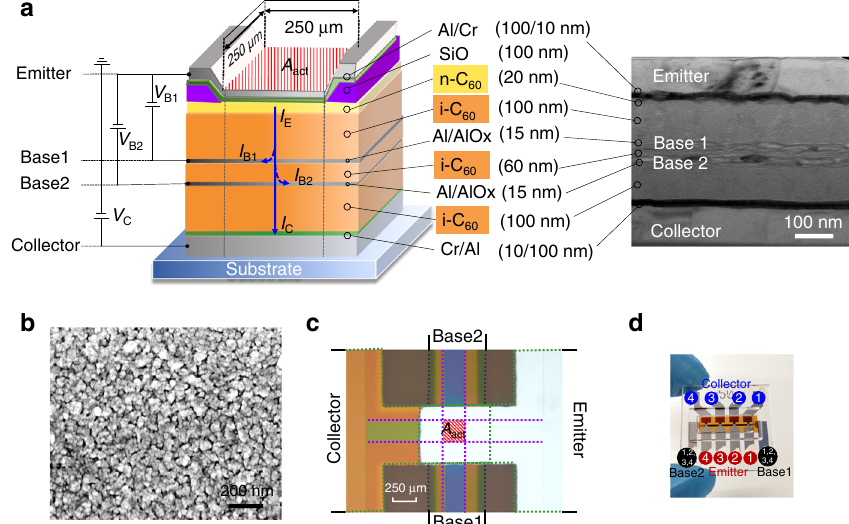
Fig. 1 Device structure and characterization. a Structure schematic view of an OPDBT measured using common-emitter con fi guration, and cross-section TEM image of an OPDBT. b SEM image of a 15-nm-thick Al covered on a C 60 layer after oxidation in ambient air. c Optical image of the active area in an OPDBT. The active area A act is de fi ned by the overlap of four electrodes: the emitter (E), base1 (B1), base2 (B2), and collector (C). An insulating layer of SiO is used to con fi ne the active area. The current fl ow happens in an effective region of 250 µ m × 250 µ m. d Photograph of our OPDBTs on a glass substrate (edge length: 1 in.), including four active OPDBT pixels. With applied base1-emitter voltages ( V B1 ) and base2-emitter voltages ( V B2 ), electrons can pass through the base and hence reach the collector ( a ). Except for a minor leakage current into the bases I B1 and I B2 (blue dotted arrows), the emitter current I E (solid blue arrow) can fi nally arrive at the collector, forming the collector current I C